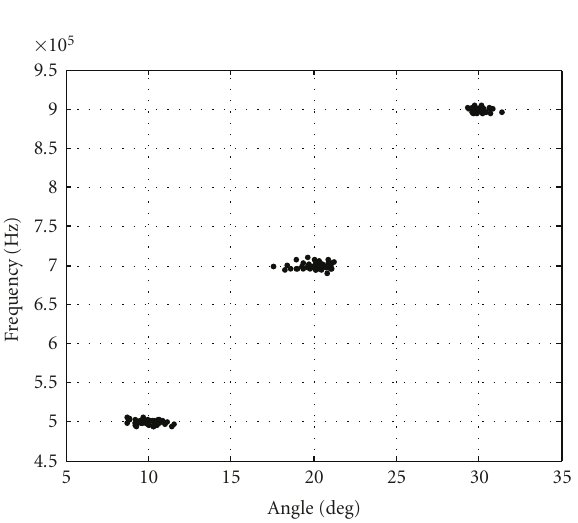
Figure 2: Angle-frequency scatter, SNR = 15dB.